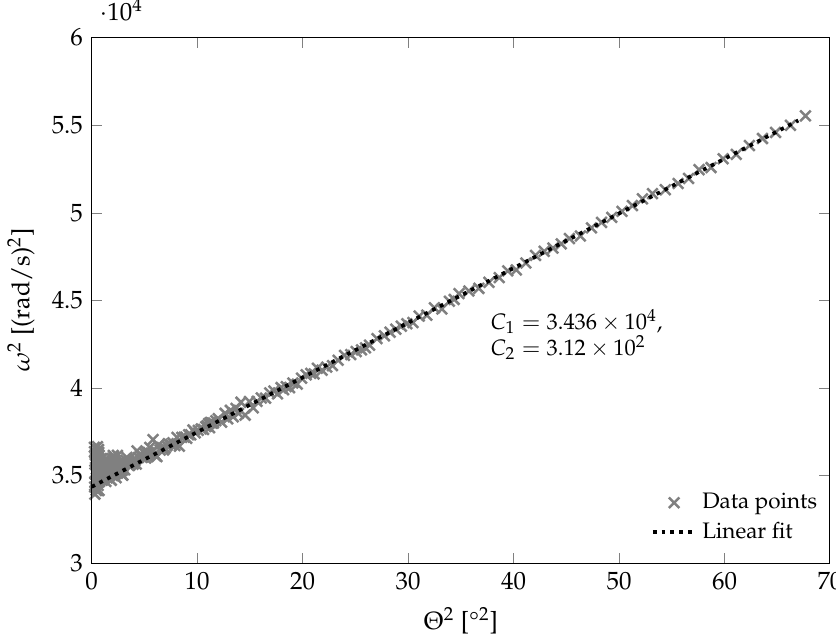
Figure 6. Least-squares fit to data to obtain stiffness coefficients based on Equation